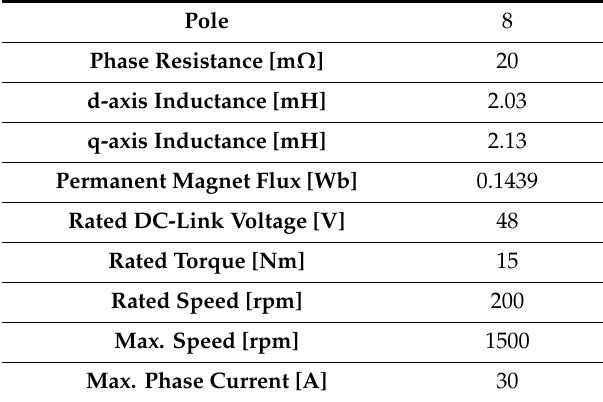
Figure 7. Experimental setup: ( a ) Picture of the setup; ( b ) composition of the setup. Table 1. Test motor